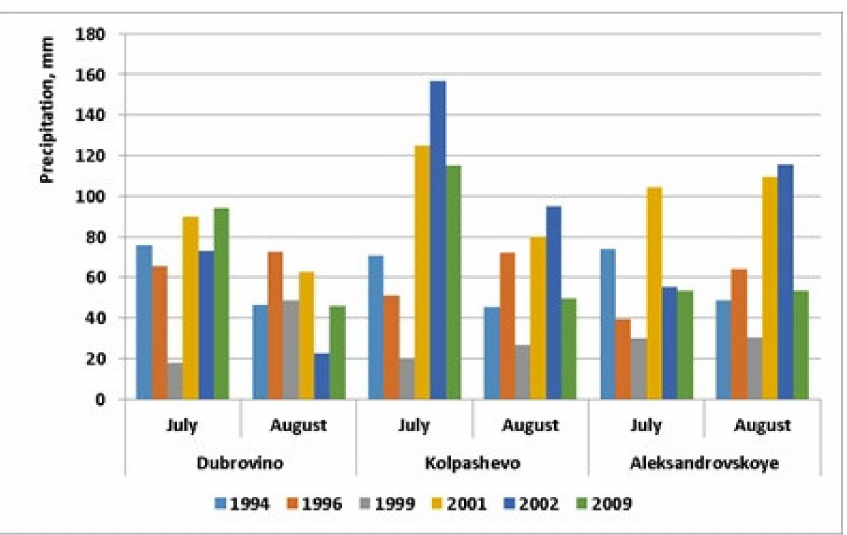
Figure 4. Monthly precipitation amount